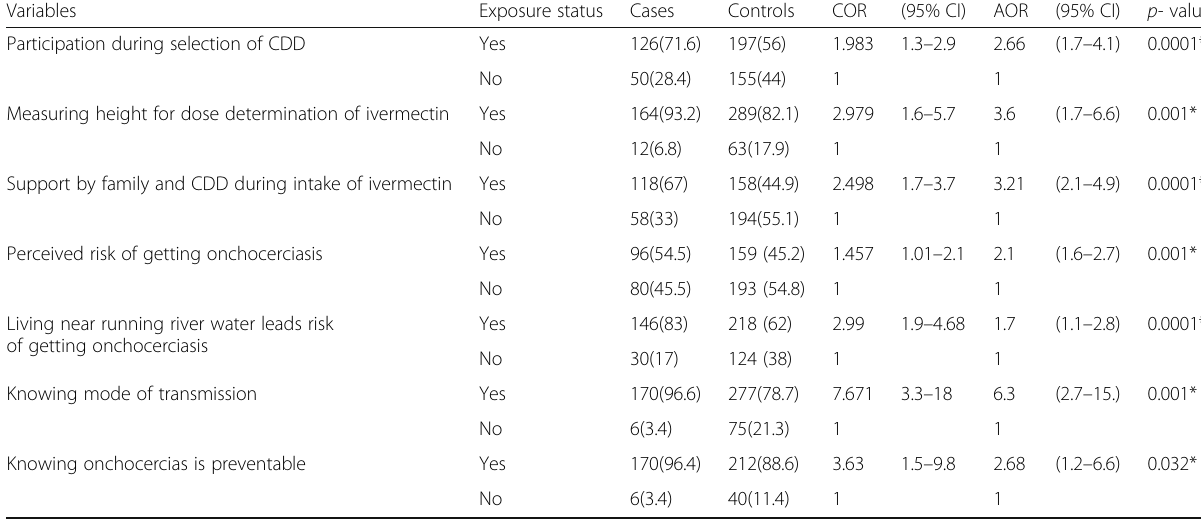
Table 2 Determinants of ivermectin adherence among beneficiaries in Assosa District, Western Ethiopia, 2017